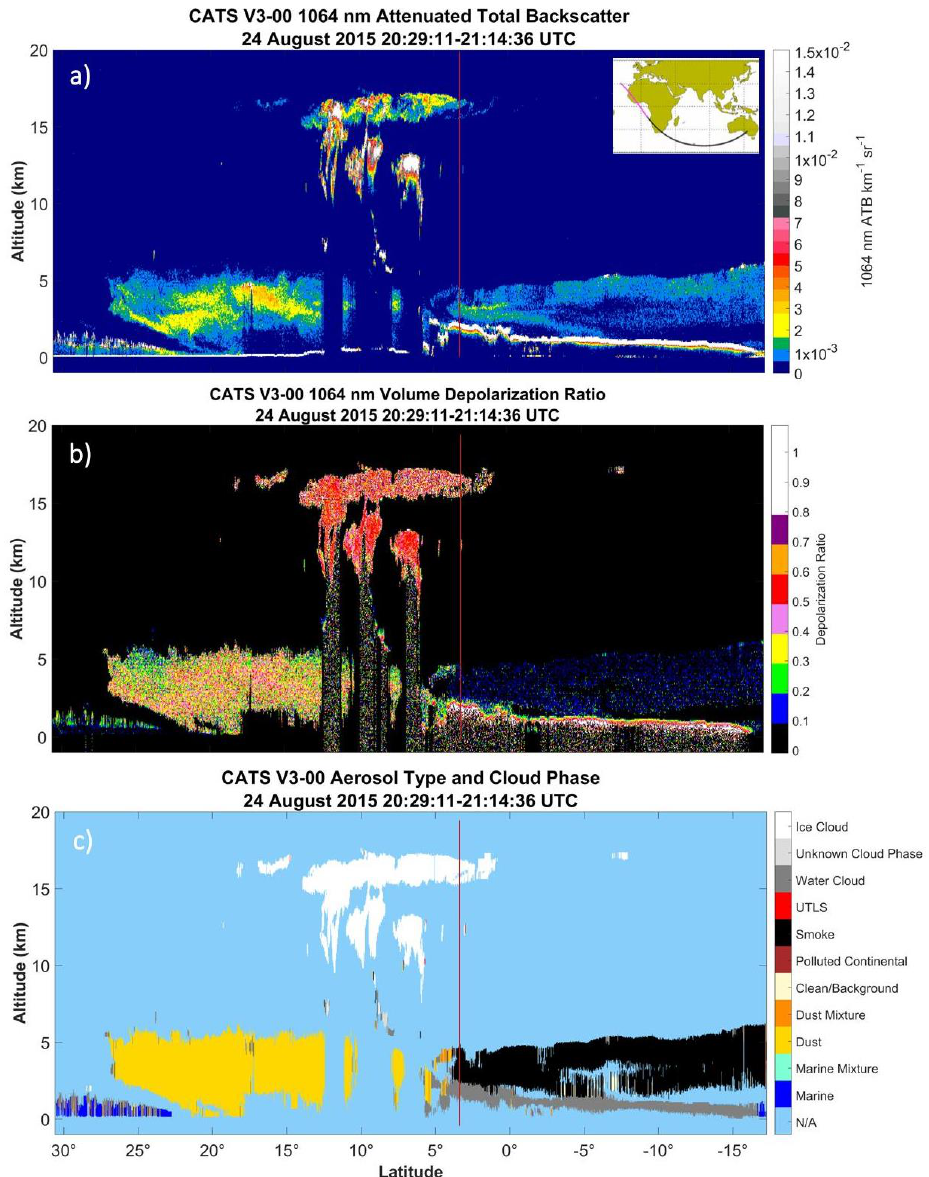
Figure 1. The CATS 1064 nm attenuated total backscatter (ATB) ( a ), volume depolarization ratio ( b ), and vertical feature type ( c ) on 24 August 2015 near the west coast of Africa. The red line shows the location of the vertical profile plotted in Figure